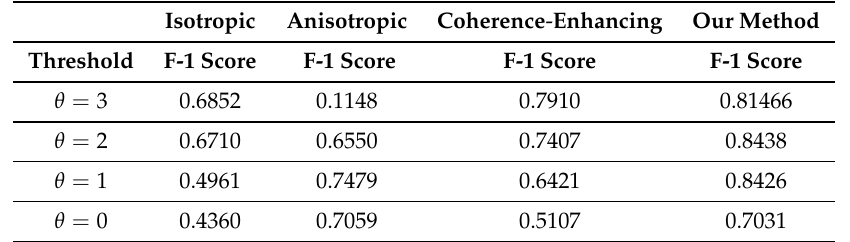
Table 2. Quantitative evaluation of the detection of curvilinear structures corresponding to roads in aerial images and fissures in coronal, axial, and sagittal plane CT images in terms of precision and